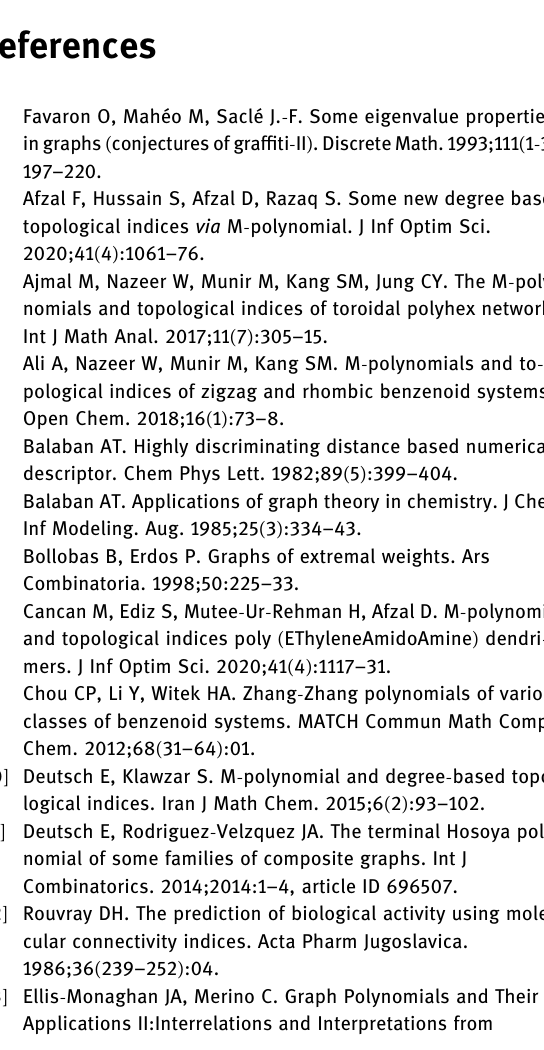
for the chemical molecule. So we calculated many indices ( Table 1 ) via M - polynomial. These topological indices can be helpful to know about the physical characteristics, biological functions and chemical behavior. In this per - ception, topological index can be considered as a key role, which converts the chemical structure into a real number and can be utilized to describe the chemical graph under consideration. We also visualize our result of topological indices. These representations of topolo - gical indices with the help of graphs explain that the value of the speci fi c index dependent on the molecular